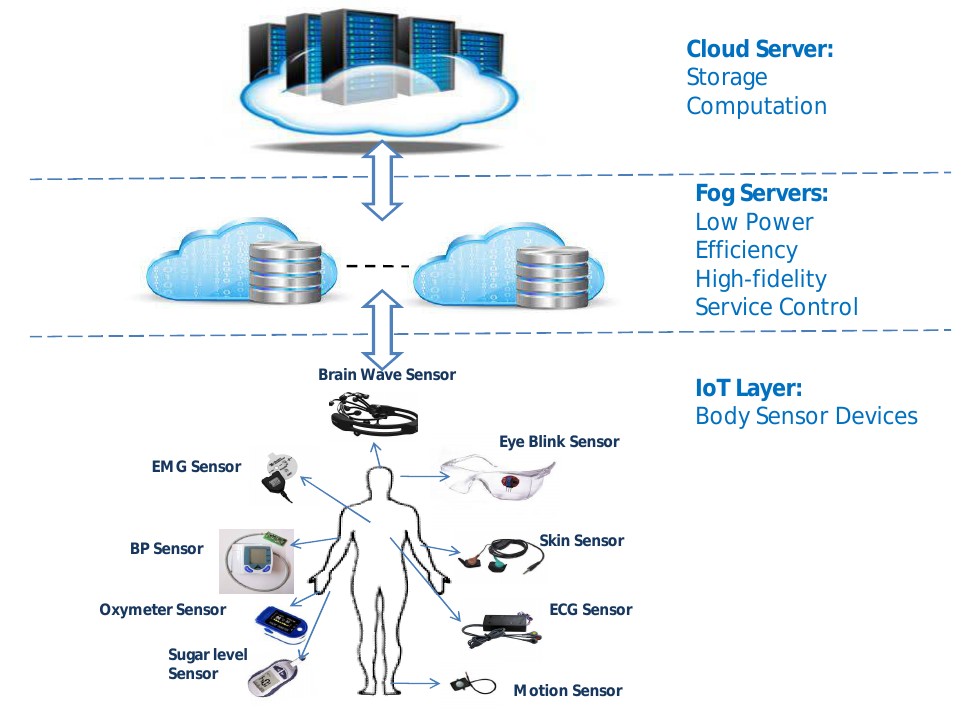
Figure 1. Architecture of fog computing in